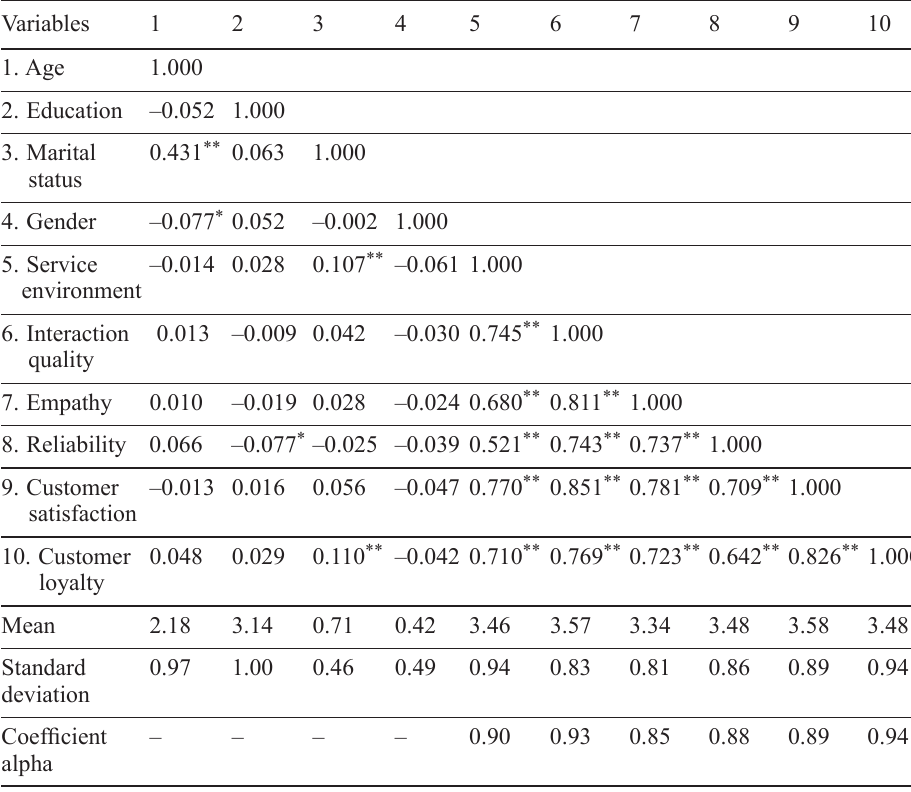
Table 3. Scale reliabilities, means, standard deviations, and correlations of study